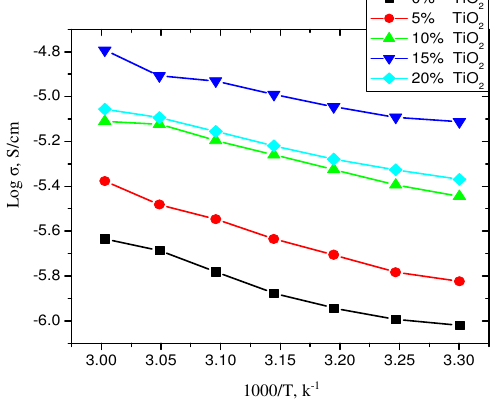
Figure 3. Temperature dependent ionic conductivity for all samples